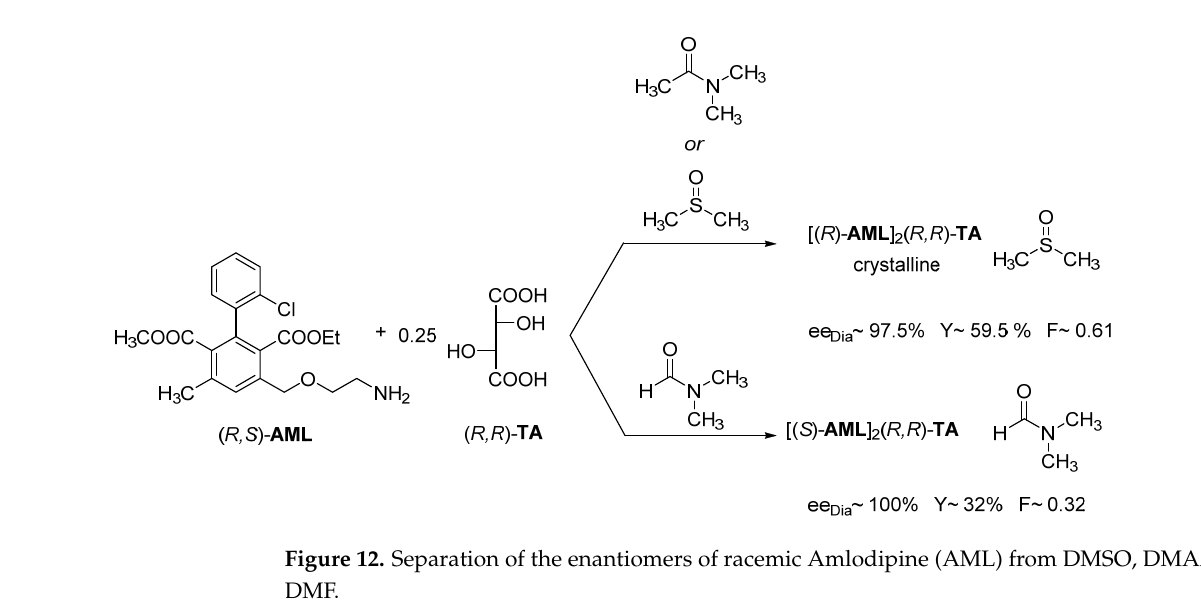
Figure 12. Separation of the enantiomers of racemic Amlodipine ( AML ) from DMSO, DMAA, and DMF.